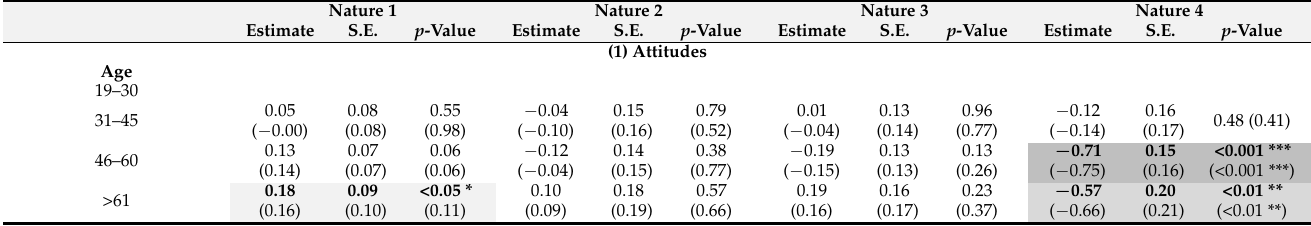
Table A3. Predictive potential of respondents’ socio-demographic background for attitudes and emotions towards the four nature types. Results of the generalized linear models with estimate, standard error (S.E.) and p -value (* p < 0.05; ** p < 0.01; *** p < 0.001). Significant results shown in bold and highlighted in shaded grey. Analysis without n = 48 (participants that did not indicate their postal code) in